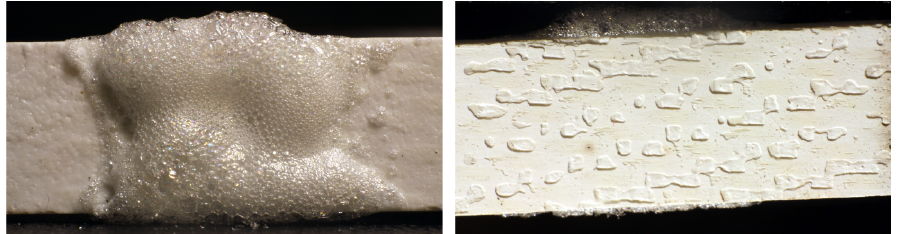
Figure 19. ( left ) glaze foamed on the side facing the flame and ( right ) apparently undamaged substrate material on the reverse side.